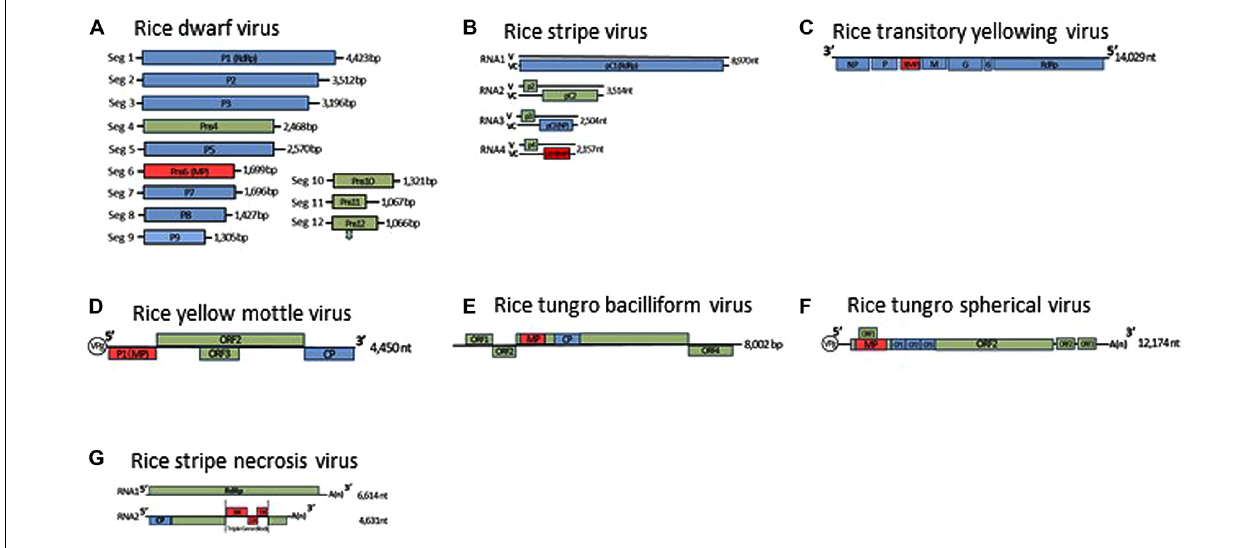
FIGURE 1 | Genome organization of rice dwarf virus (A), rice stripe virus (B), rice transitory yellowing virus (C), rice yellow mottle virus (D), rice tungro bacilliform virus (E), rice tungro spherical virus (F), and rice stripe necrosis virus (G). Lines represent the viral genomic segments. Blue boxes